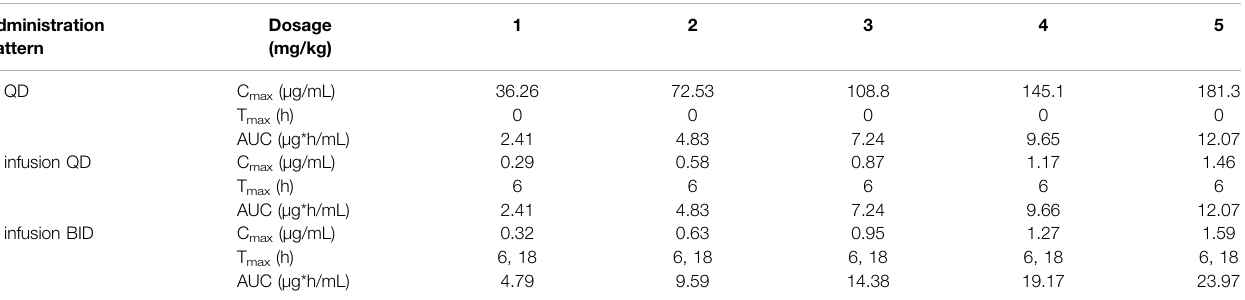
TABLE 6 | Predicted dose-dependent pharmacokinetic parameters of ST-246 in humans after IV, 6-h IV infusion QD, and 6-h IV infusion BID administration. Administration